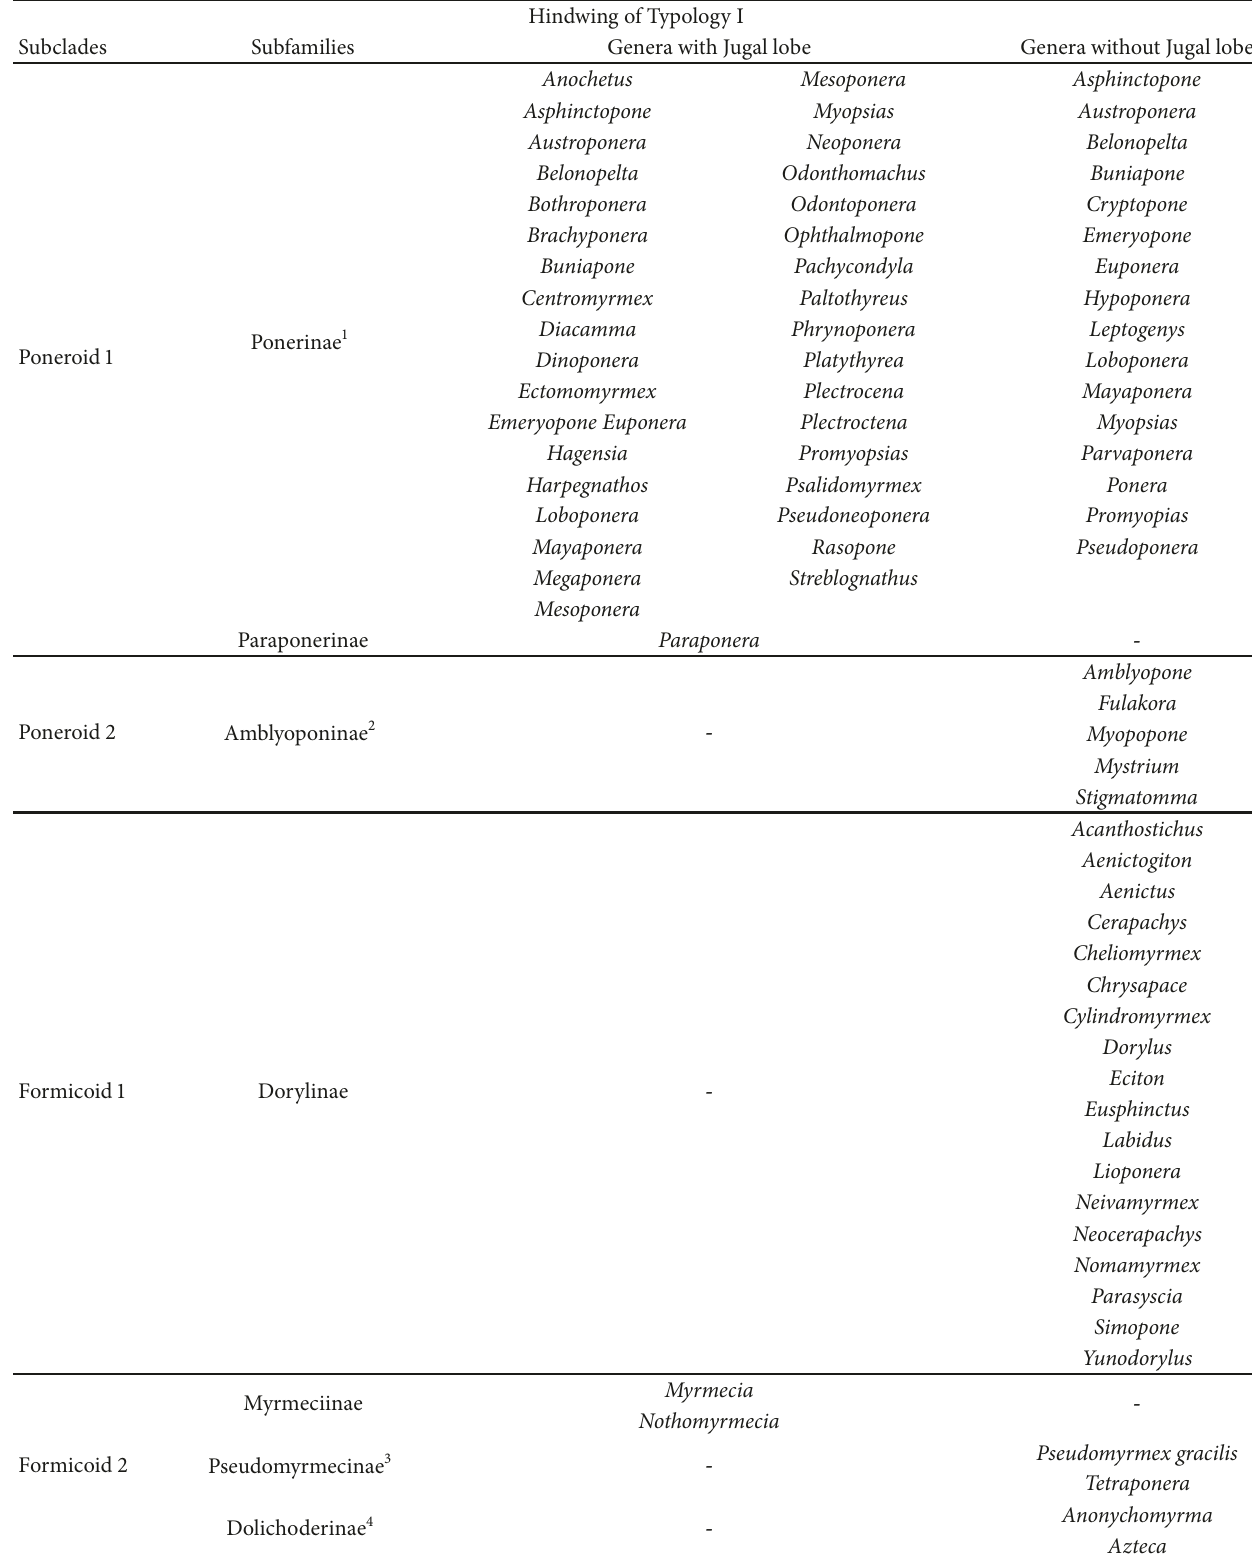
Table 1: Genera with hindwing of Typology I divided for